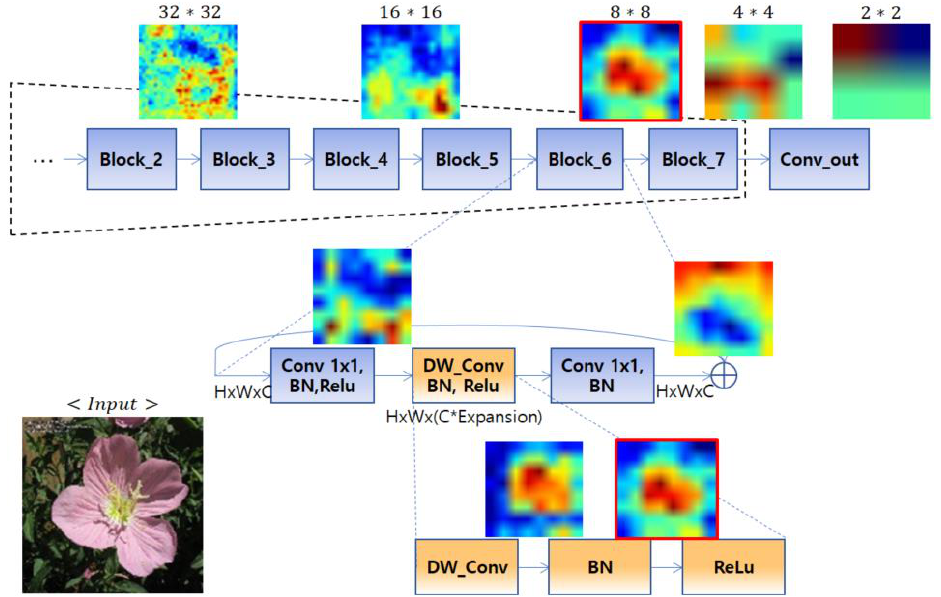
Figure 5. Activation map of the CEVAE.